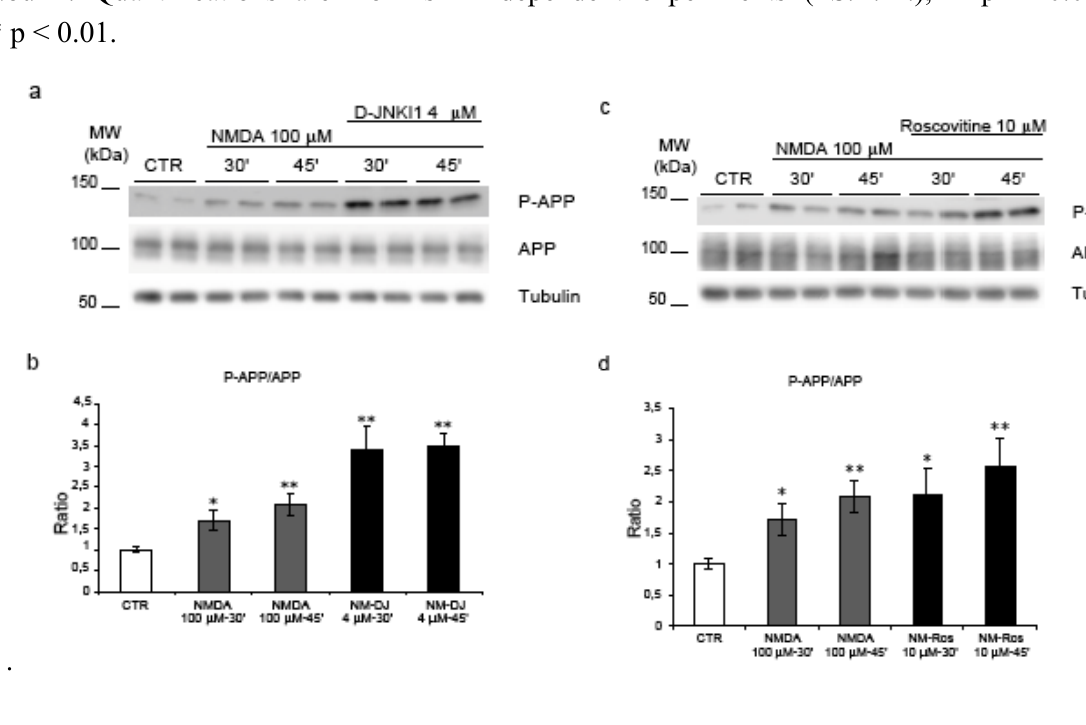
Figure 5. JNK and Cdk5 inhibition do not reverse NMDA induced APP hyperphosphorylation. (a) Neurons were pre-treated with D-JNKI1 and then exposed to NMDA (30’-45’). (b) Western blot analysis and quantification showed that co-treatment with D-JNKI1/NMDA did not reduce P-APP increment induced by NMDA alone. On the contrary, D-JNKI1 pre-treatment increased P-APP/APP level. (NM = NMDA, DJ = D-JNKI1) (c) Neurons were pre-treated with Roscovitine and then exposed to NMDA. (d) Roscovitine did not reduce P-APP following NMDA application. Roscovitine/NMDA co-treatment further increased P-APP/APP levels compared to controls. (Ros = Roscovitine) Loading